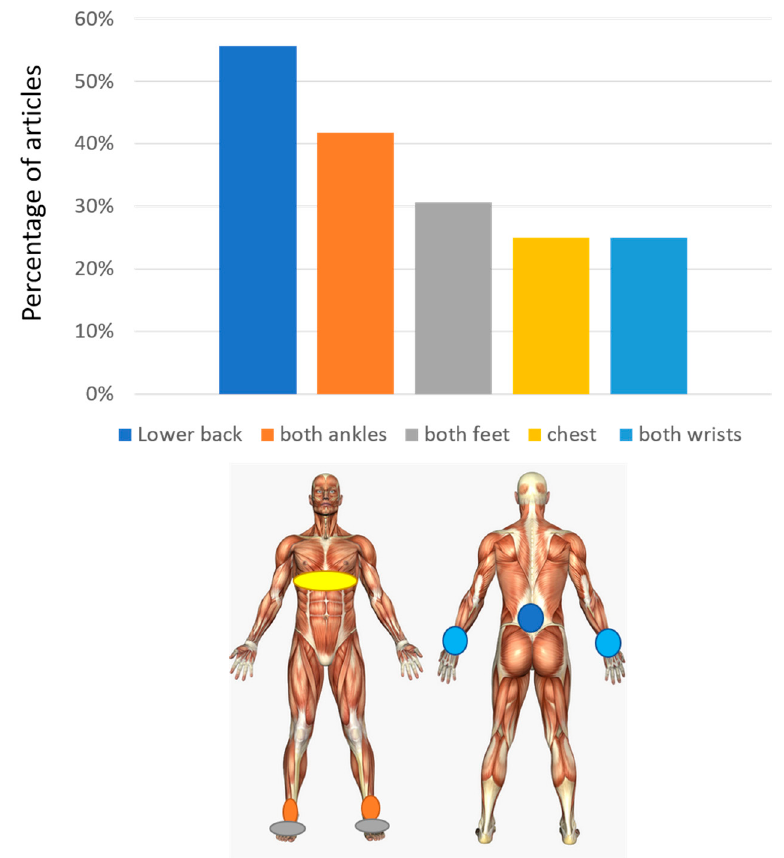
Figure 3. Sensor placement. At the top, the percentage of studies involving a sensor on different positions is reported. At the bottom, the corresponding position of sensors with respect to the body is reported.